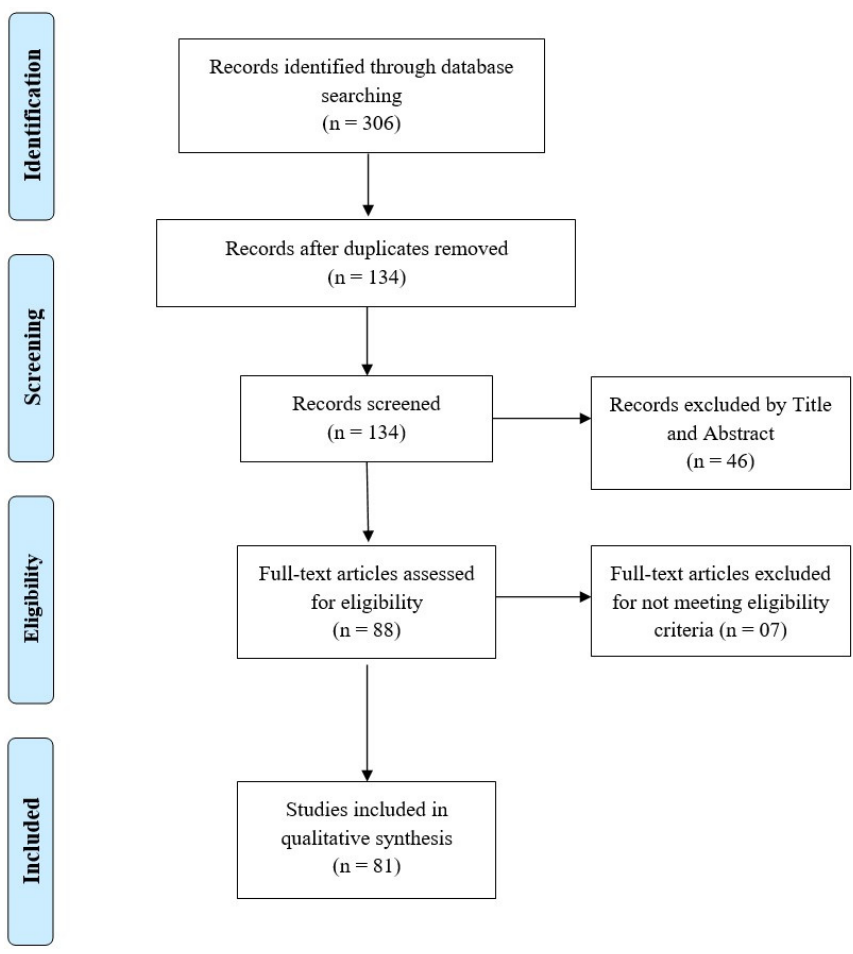
Figure 1. Study identification PRISMA flowchart.